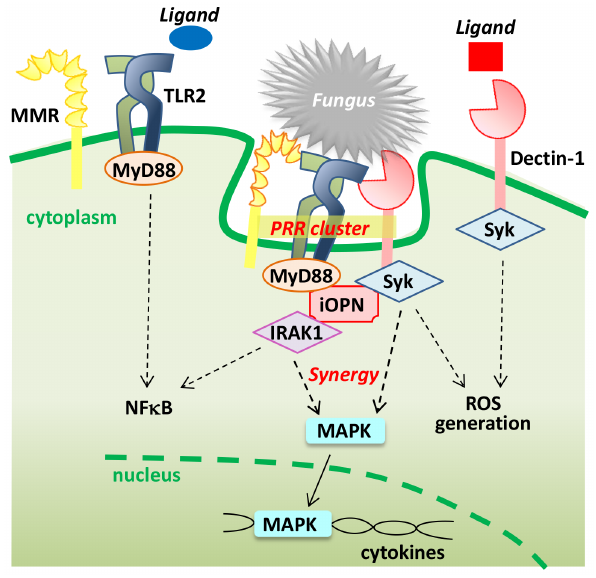
Figure 1. A model example of a PRR cluster formation for fungal detection. Soluble ligands do not make a PRR cluster, but a fungal spore or a particulate ligand attracts PRRs in a lipid raft on the host cell surface. In this figure, heterologous PRRs, consisting of dectin- 1, TLR2, and MMR, form a PRR cluster.